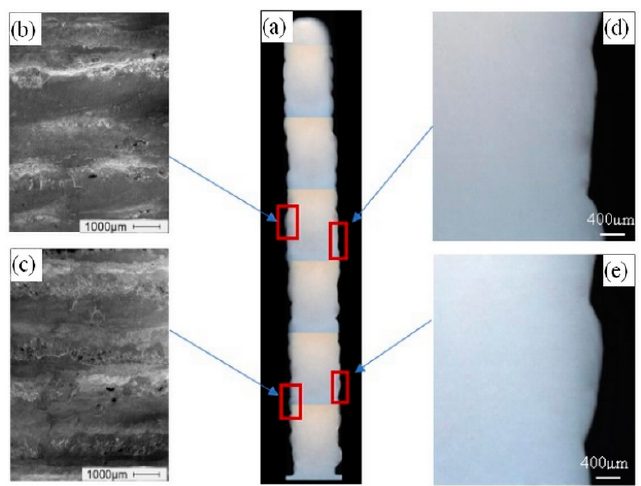
Figure 5. Assessment of the surface quality of the component: ( a ) Overall condition on cross section; ( b , c ) surface condition analyzed by SEM; ( d , e ) inter-layer adjacent region condition analyzed by OM.